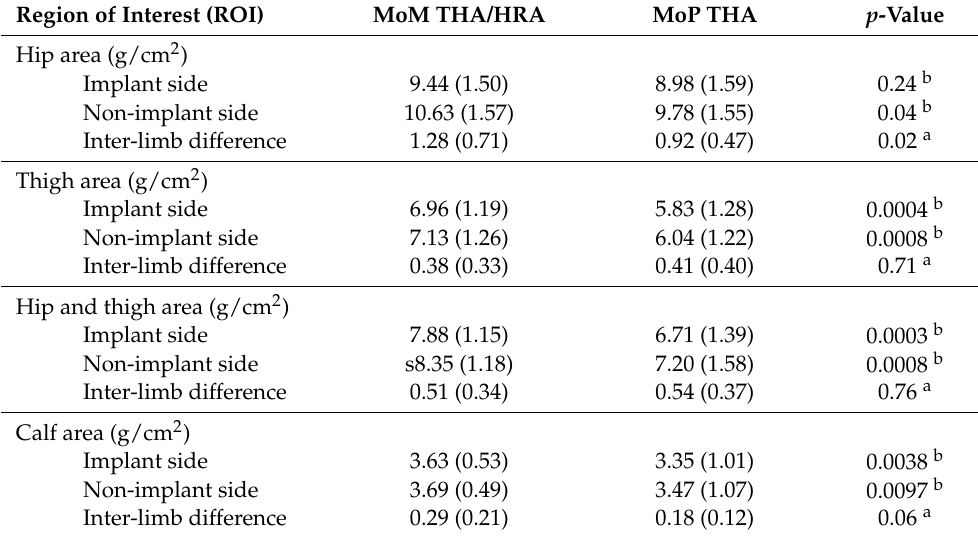
Table 2. Comparison of mean muscle mass in both legs and inter-limb difference between mean muscle mass in MoM THA/HRA ( n = 51) and MoP THA ( n = 23). Values are mean (SD). Region of Interest (ROI) MoM THA/HRA MoP THA p -Value Hip area (g/cm 2 ) Implant side